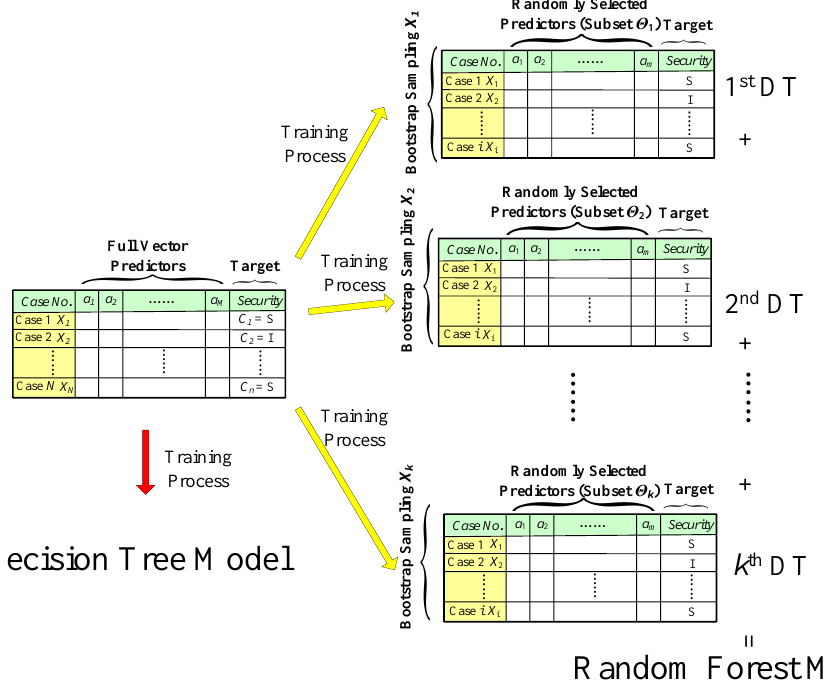
Figure 2. The procedure of training a Random Forest model.